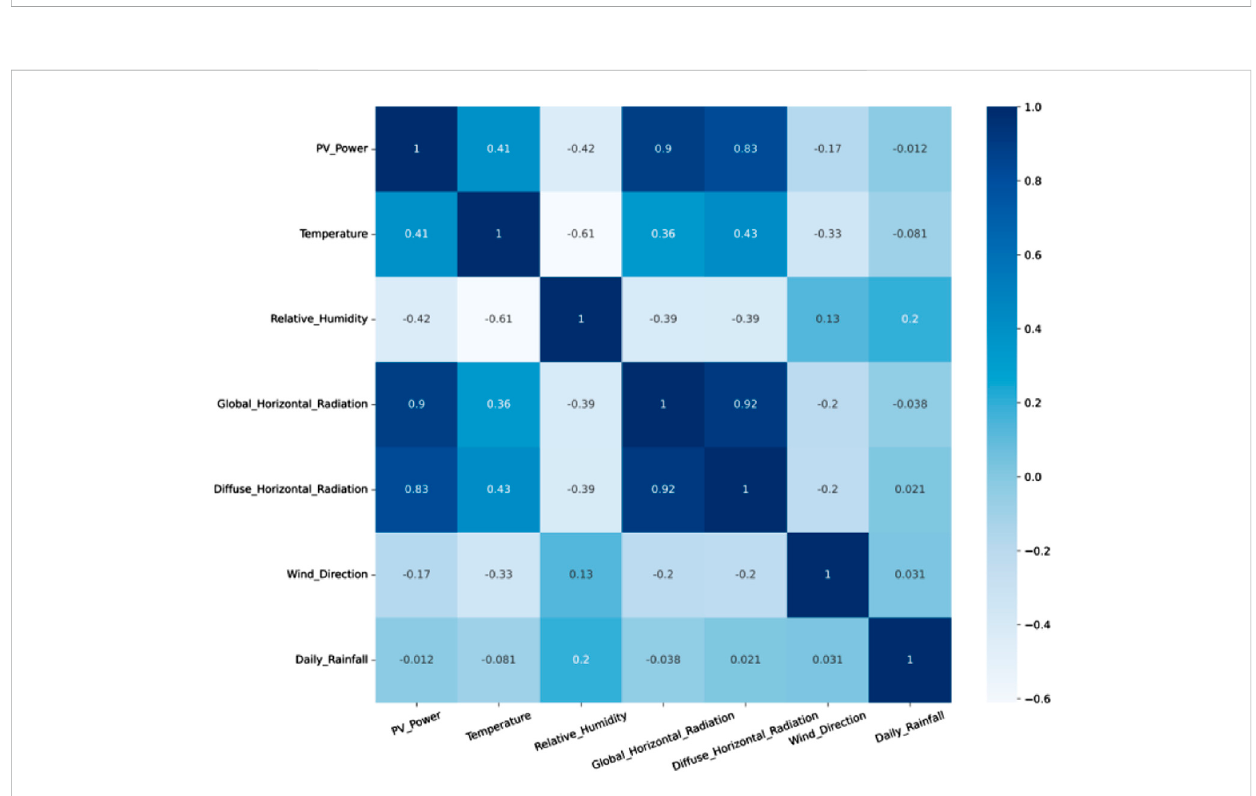
FIGURE 8 Results of SCC correlation